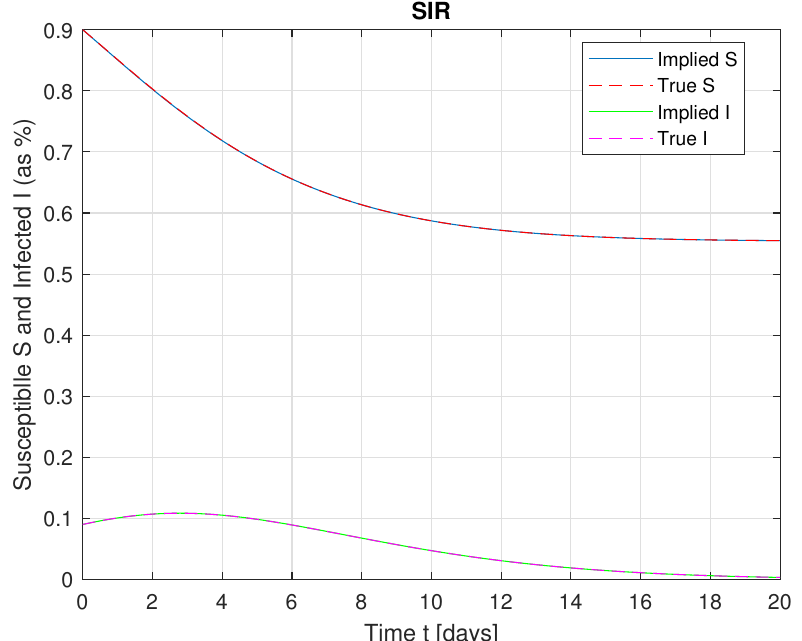
Figure 3. Recovered susceptible S and infected I population with